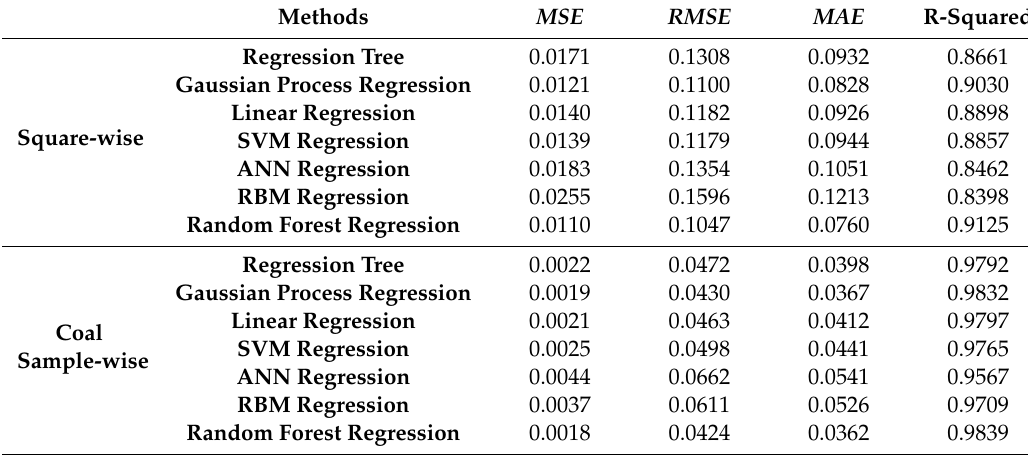
Table 4. Quantitative assessment of di ff erent MMVR regression models *. MSE , mean squared error; RMSE , root mean square error; MAE , mean absolute error; ANN , artificial neural network; RBM, restricted Boltzmann machine; SVM, support vector machine.